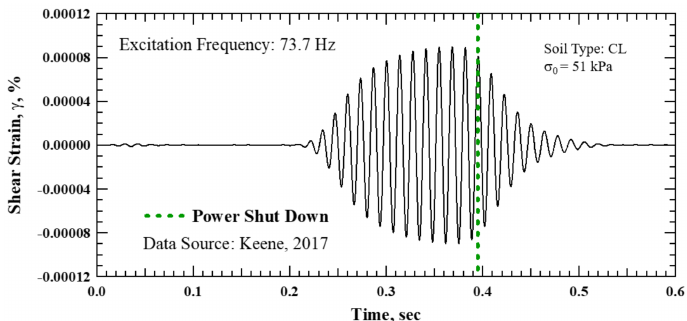
Figure 15. Butterworth bandpass filtered FVD